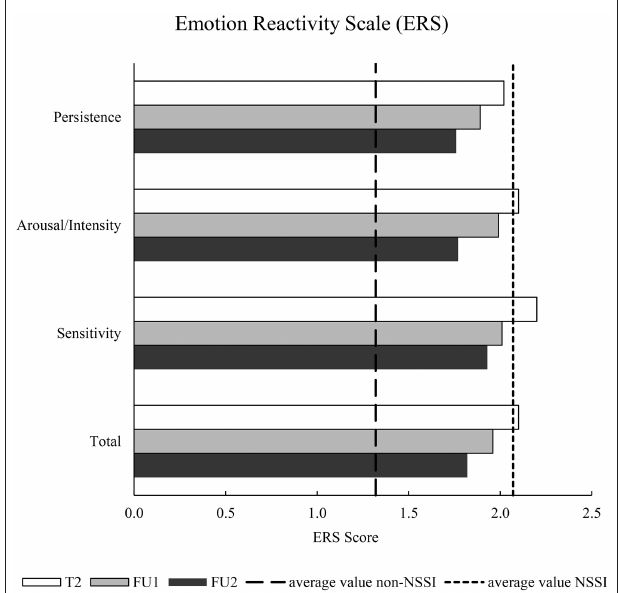
FIGURE 2 | Descriptive Emotion Reactivity Scale results over all examination time points. Survey time points: baseline examination (T2), follow-up 1 (FU1), follow-up 2 (FU2); Non-suicidal Self-injury (NSSI); average values for (non) NSSI ERS scores correspond to group means from Nock et al.